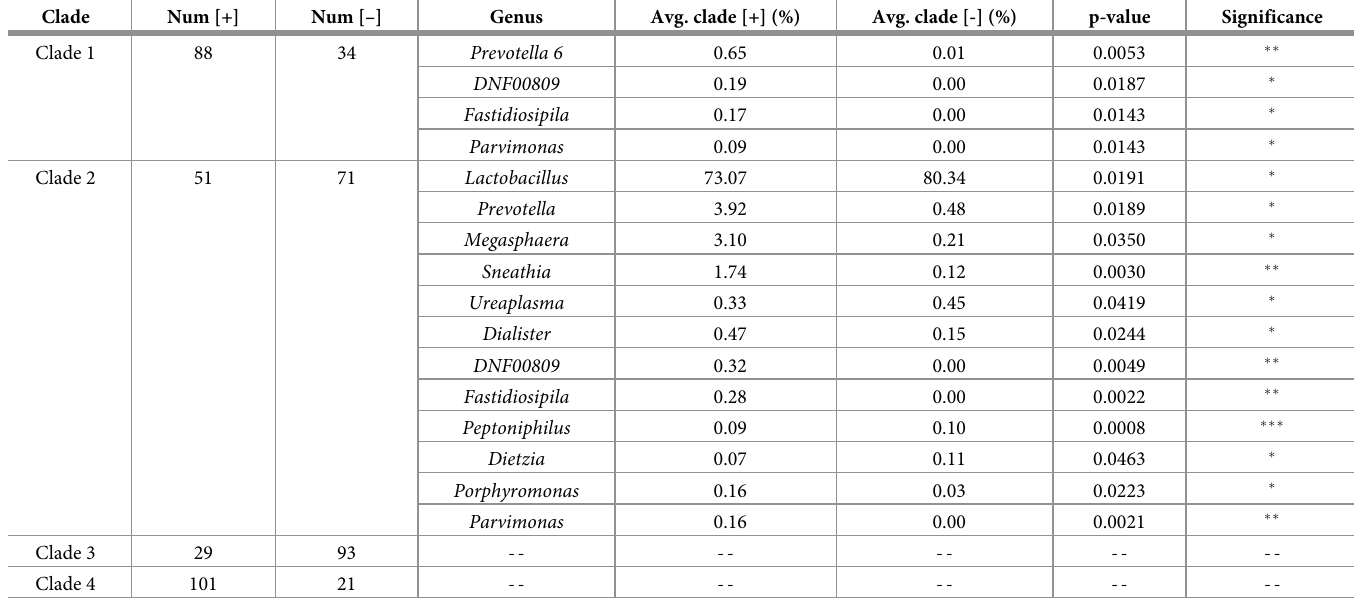
Number of samples per group, as well as the p-value of the Mann-Whitney U-test is reported. Significance was assessed using a Benjamini-Hochberg FDR correction on the 25 most abundant genera (using an FDR of 0.15 as a threshold). For better clarity, in the table, raw unadjusted p-values were provided. Asterisks indicate graphically the statistical significance: ��� : p <